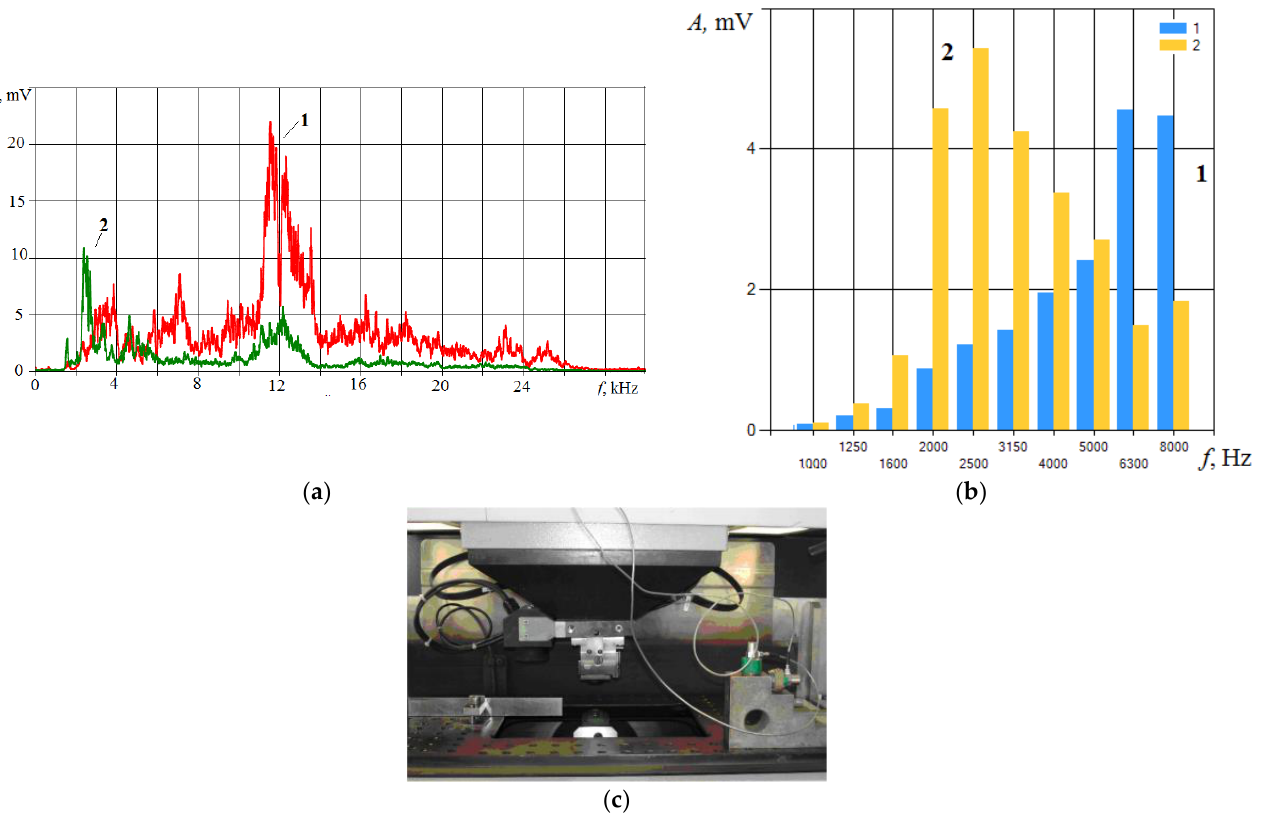
Figure 15. Examples of VA signal spectra during cutting of a workpiece of HG20 alloy: ( a ) amplitude spectrum; ( b ) 1/3 of octave spectrum; where for ( a ) and ( b ) ( 1 ) is at the machining beginning and ( 2 ) is at 1 s before the wire tool electrode breakage; ( c ) the working area of the wire electrical discharge machine with installed accelerometers.